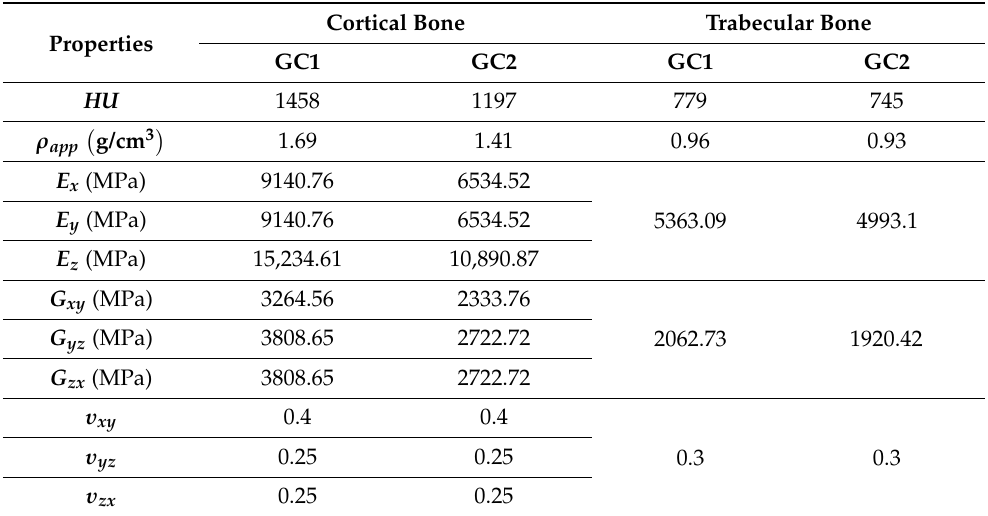
Table 1. Physical and mechanical properties of the cortical and trabecular bone of each geometric